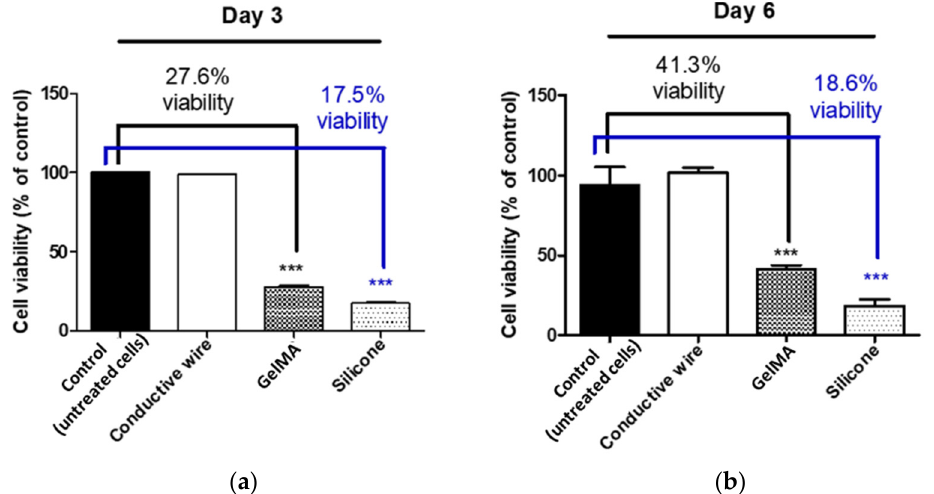
Figure 4. Cell viability as revealed by MTT assay. RAW 264.7 cells biocompatibility profile after